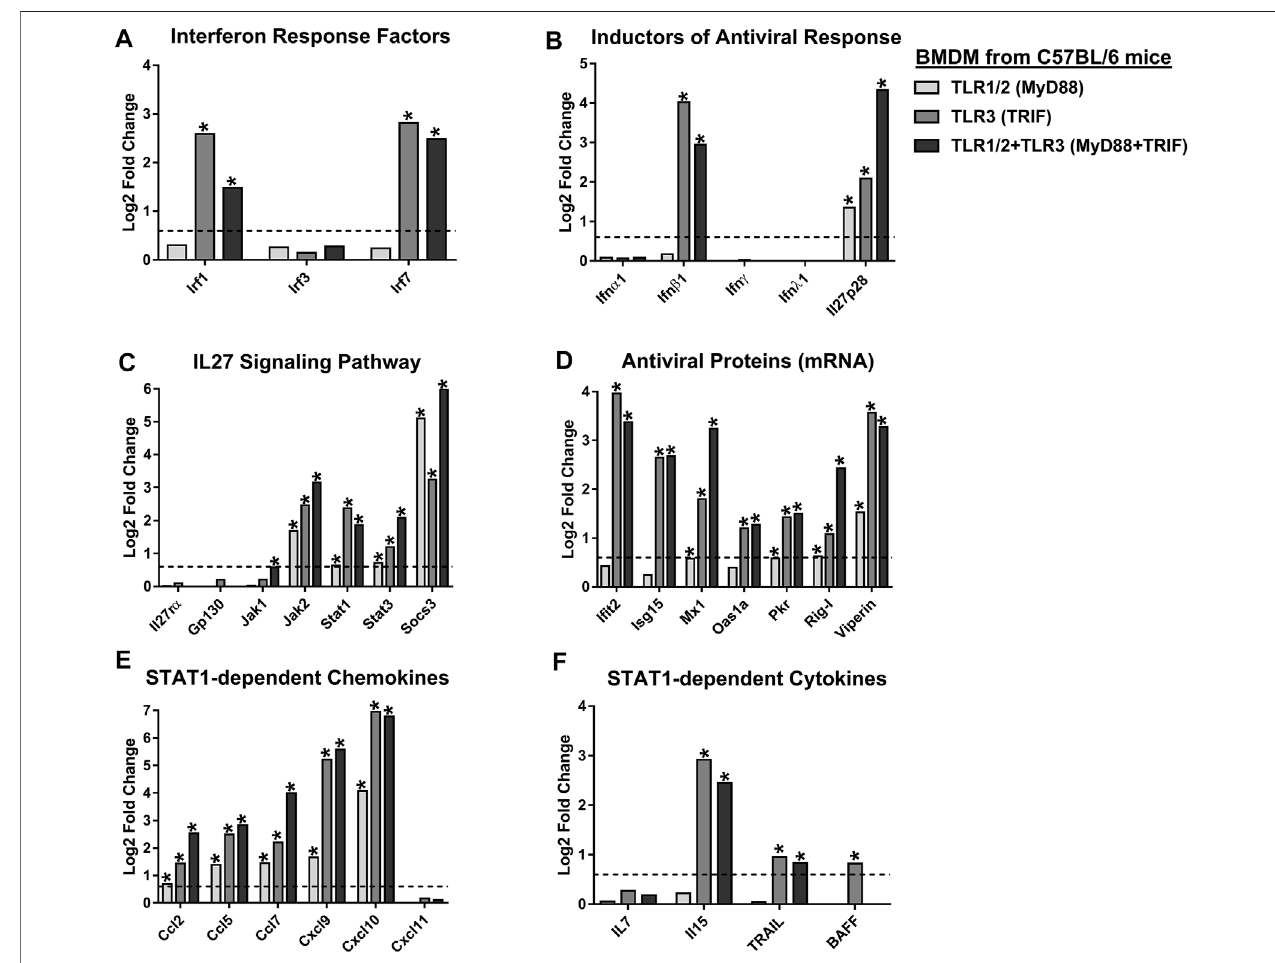
FIGURE 8 | The synergic effect between TLR1/2-MyD88 and TLR3-TRIF triggers the expression of IL27, which induces STAT1-dependent pro-in fl ammatory and antiviral response in murine BMDM. We reanalyzed the public MicroArray GSE89962 (GEO) (Lin et al., 2017), obtained from BMDM of C57BL/6 mice stimulated with 10 ng/ml Pam3CSK4 and/or 10 μ g/ml Poly (I:C), for 8 h. Differentially expressed (Log2 FC) IRFs (A) , inductors of antiviral response (B) , IL27 signaling components (C) , AVPs (D) ,STAT1-dependentCC-andCXC-chemokines (E) ,andSTAT1-dependentcytokines (F) .DEGswerede fi nedasgeneswithanFDR < 0.05and|Log2Fold Change (TLR-treated BMDM/unstimulated BMDM) | > 0.6. Signi fi cant results are de fi ned as p < 0.05 (*). n =